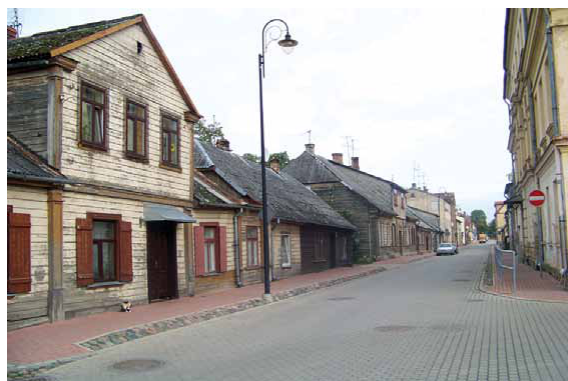
Fig. 11. The building scale in riga street no trees.